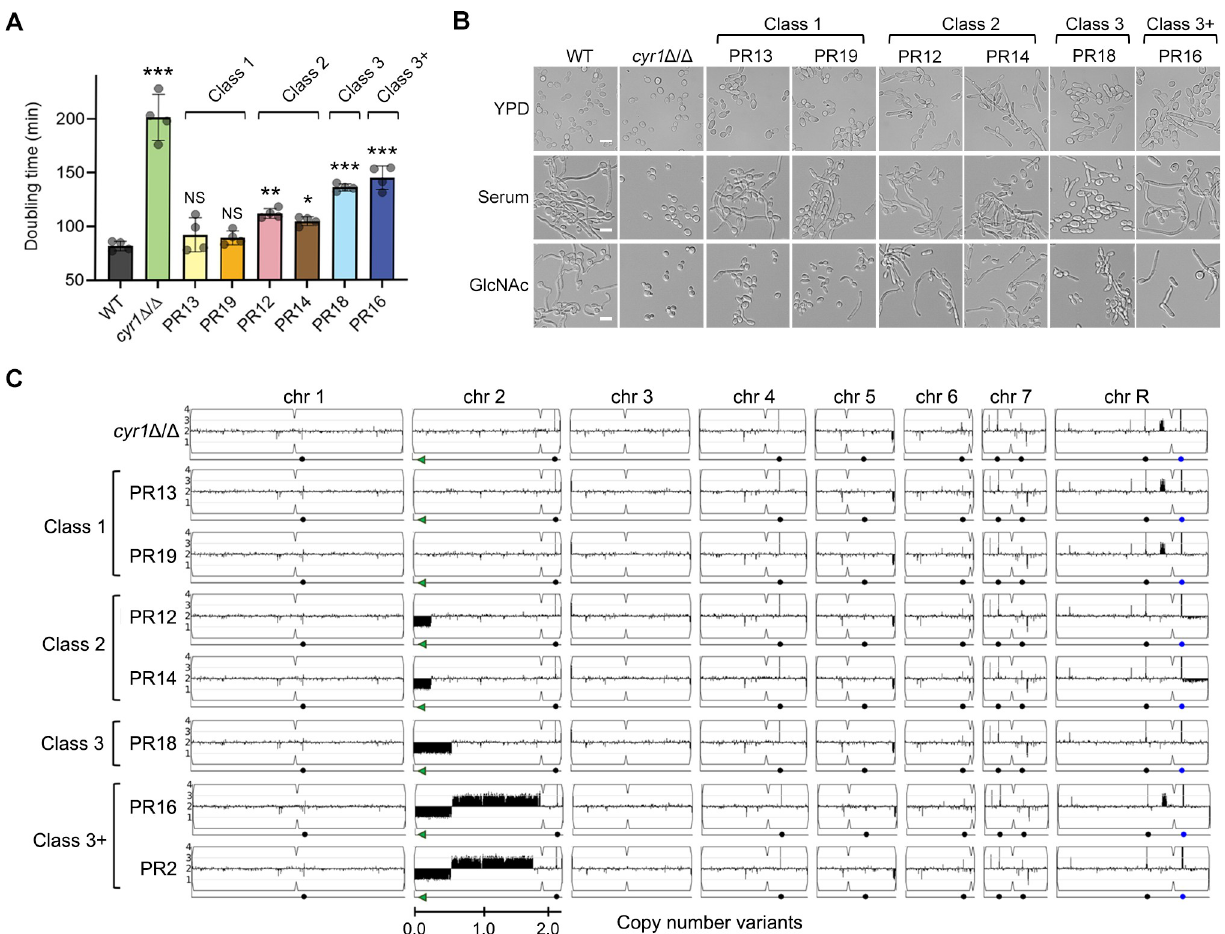
Fig 1. Genetic changes in chromosome 2 bypassed the need for cAMP to improve growth and hyphal induction in cyr1 Δ / Δ PR mutants. (A) Doubling times were measured in liquid YPD medium at 30˚C. Shown is the mean ± SD (standard deviation) of 4 independent experiments. Statistical analysis was performed using one-way ANOVA with Dunnett’s multiple comparisons test comparing the strains with the wild-type control (WT); NS p > 0.05, � p < 0.05, �� p < 0.01, ��� p < 0.001. The doubling time of the strains shown was significantly shorter when compared to the cyr1 Δ / Δ background (p < 0.0001). (B) The strains indicated at the top were grown in the liquid medium indicated on the left, and then hyphal induction was assessed microscopically. Cells were grown in liquid medium containing 15% serum or 50 mM N-acetylglucosamine (GlcNAc) to induce hyphal growth. Cells were incubated at 37˚C for 3 h and then photographed. Scale bar, 10 μ m. (C) Copy number variation analysis based upon read depth across the genome. Copy number estimates scaled to genome ploidy (Y-axis) and chromosome location (X-axis) were plotted using YMAP [91]. Numbers and symbols below chromosomes indicate chromosomal position (Mb), BCY1 gene (green arrows), centromere locus (indentations in the chromosome cartoon), major repeat sequence position (black circles), and rDNA locus (blue circles,